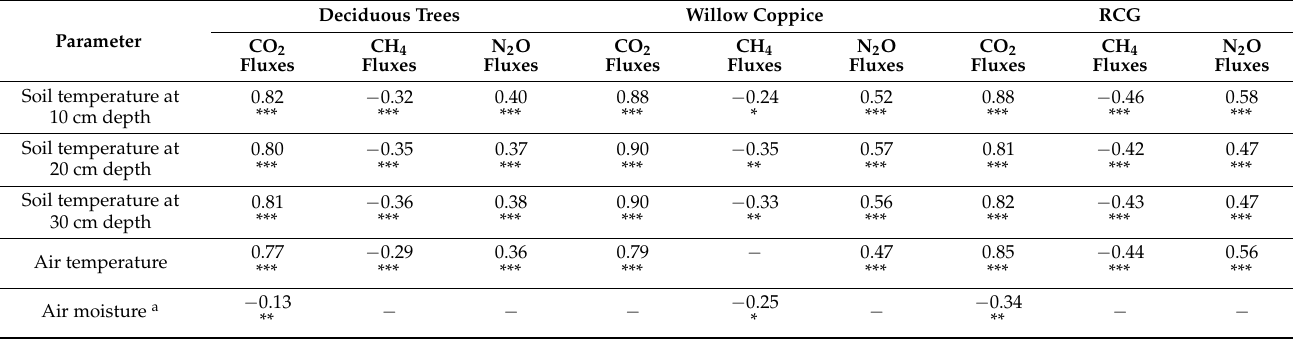
Table 3. Spearman’s correlation coefficients ( ρ ) characterising relationship between soil GHG fluxes and environmental factors (temperature and moisture), grouped by dominant vegetation type (decid- uous trees, willow coppice or RCG) in plots of agroforestry systems. * p < 0.05, ** p < 0.01, *** p < 0.001, non-significant values ( p > 0.05) are not